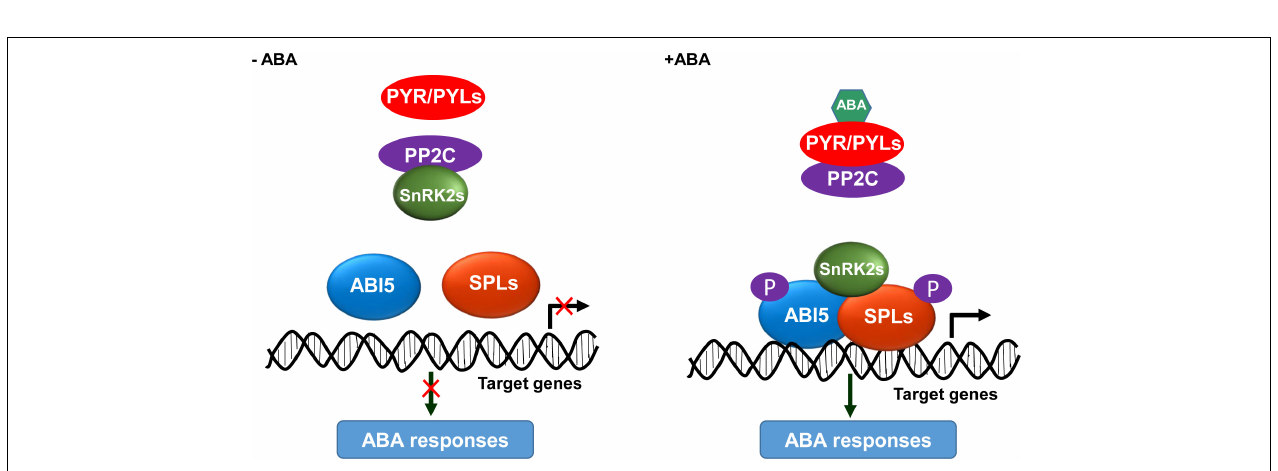
FIGURE 7 | A proposed working model for the SnRK2s-SPLs-ABI5 module in activating ABA responses. In the absence of ABA, PP2C interacts with and dephosphorylates SnRK2s; consequently, ABI5 and SPLs are inactive and unable to activate the ABA responses. In the presence of ABA, its receptors PYR/PYLs interact with PP2C to release the inhibition on SnRK2s activity; thereby, SnRK2s interact with and phosphorylate ABI5 and SPLs, leading to their enrichment at the promoter of target genes to activate ABA responses.